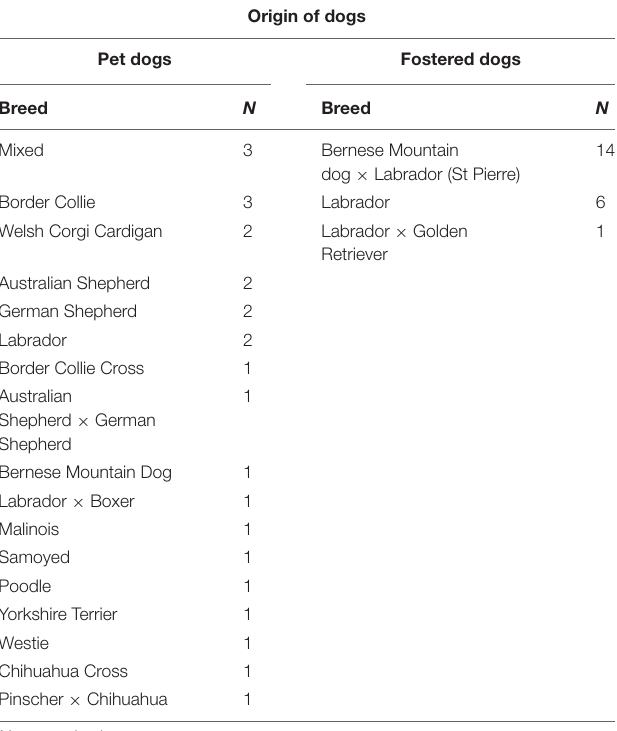
TABLE 2 | Breed differences between pet versus fostered